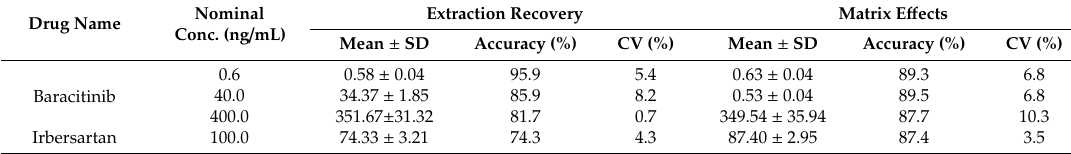
Table 2. Recovery and matrix e ff ect of baracitinib and IS in rat plasma ( n = 6).